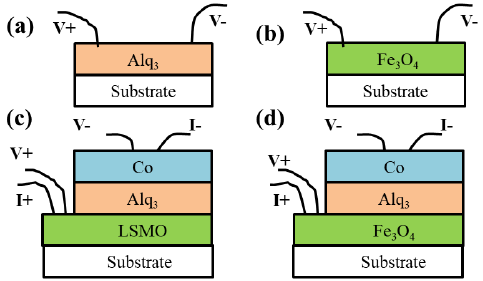
Figure 1. Device structures of ( a ) Alq 3 thin film with Cu/Al interconnects, ( b ) Fe 3 O 4 thin films with Cu/Al interconnects, ( c ) Fe 3 O 4 /Alq 3 /Co magnetic tunnel junction(MTJ), ( d ) La 0.7 Sr 0.3 MnO 3 (LSMO)/Alq 3 /Co